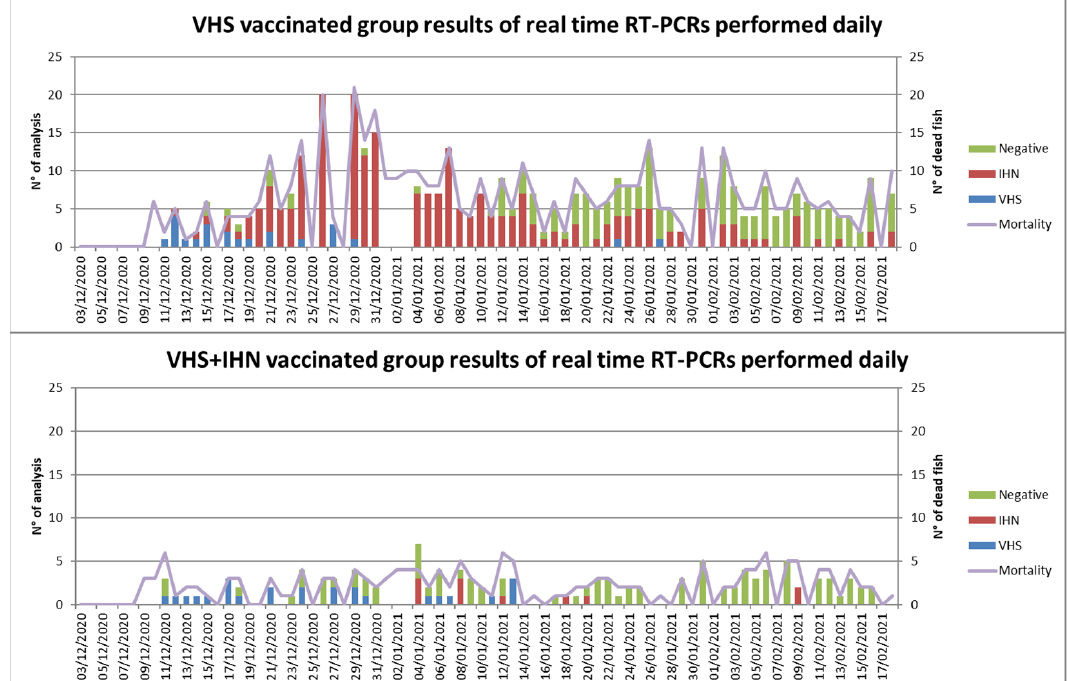
Figure 5. Daily results of the real-time RT-PCR performed on each sampled head kidney from VHS